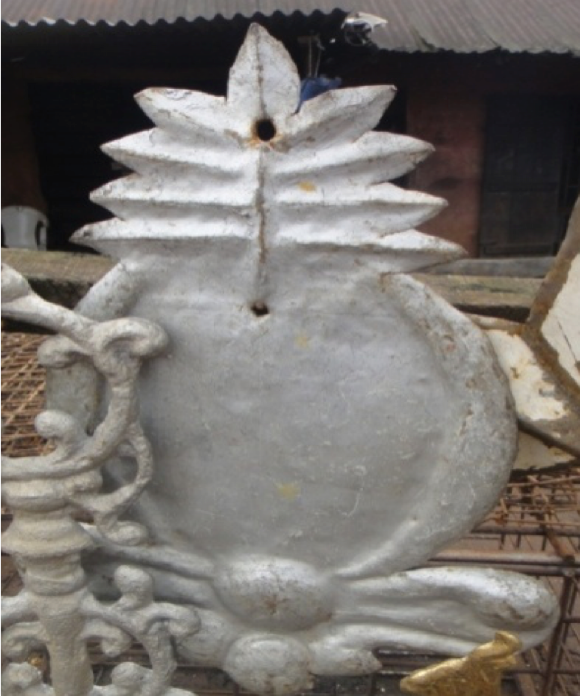
Figure 10 | A carbon steel floral shield rendered in chasing and repousse working technology (called beating by the blacksmiths). Photograph by Kingsley O. Emeriewen, 2012.